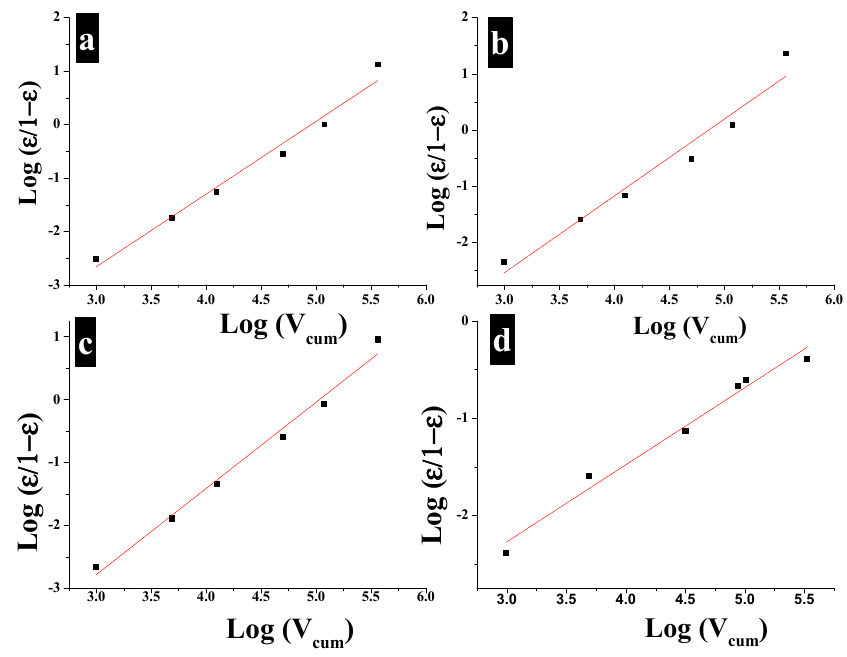
Figure 9. Hill plot: ( a ) adsorption of ARS by composite carbon; ( b ) desorption of ARS by composite carbon; ( c ) total phase between ARS and composite carbon; and ( d ) total phase between ARS and NC.